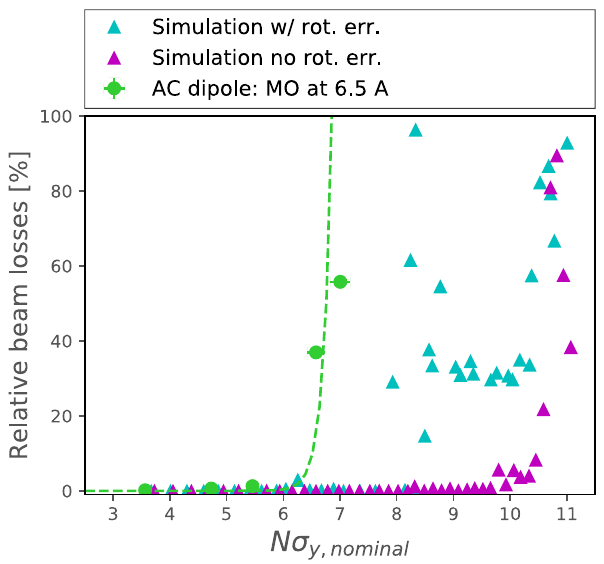
FIG. 19. Measured losses for ac dipole excitations with Landau octupoles at 6.5 A from measurements and multiparticle simu- lations. The simulations results without geometrical rotational lattice errors are shown in pink, while the simulations including those rotational errors are shown in light